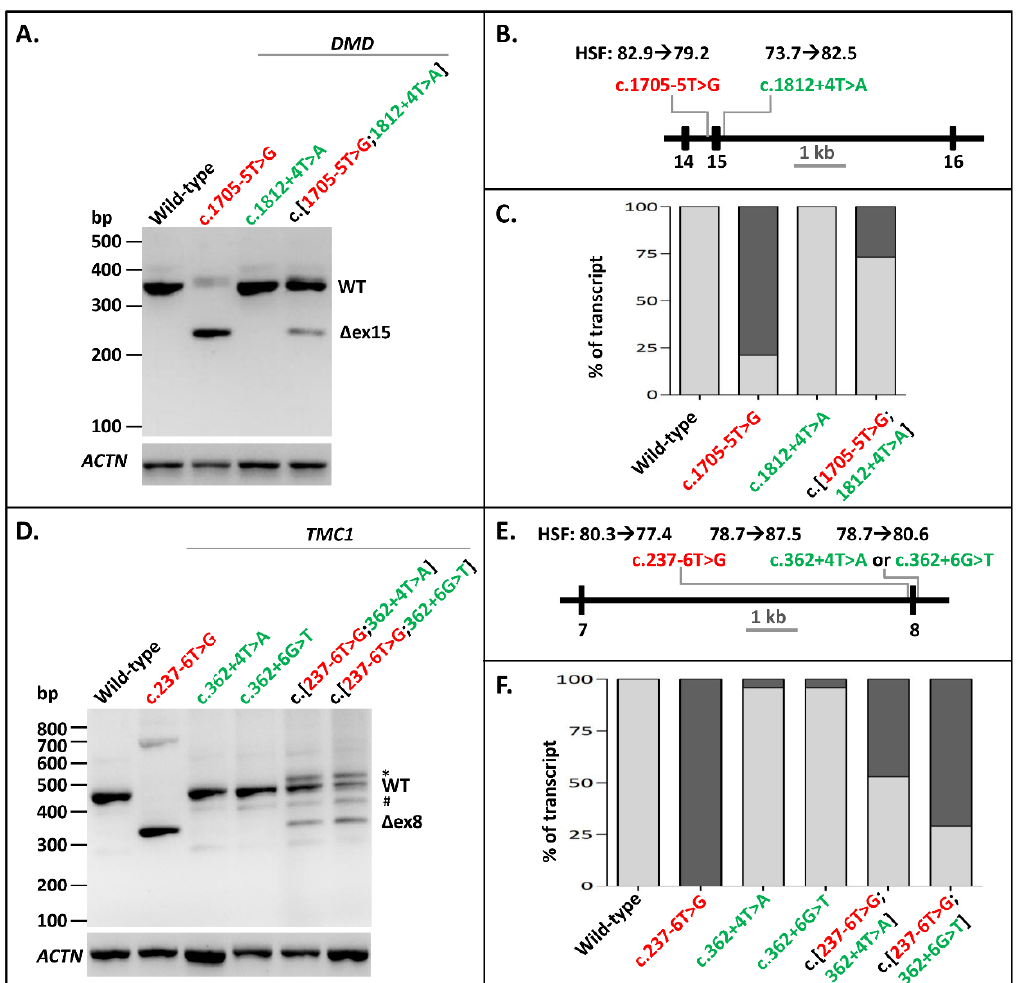
Figure 2. Splice defect rescue of pathogenic 3′-splice-site variants in DMD and TMC1 through 5′- splice-site strengthening. A. The effect of the pathogenic variant c.1705-5T>G alone, the